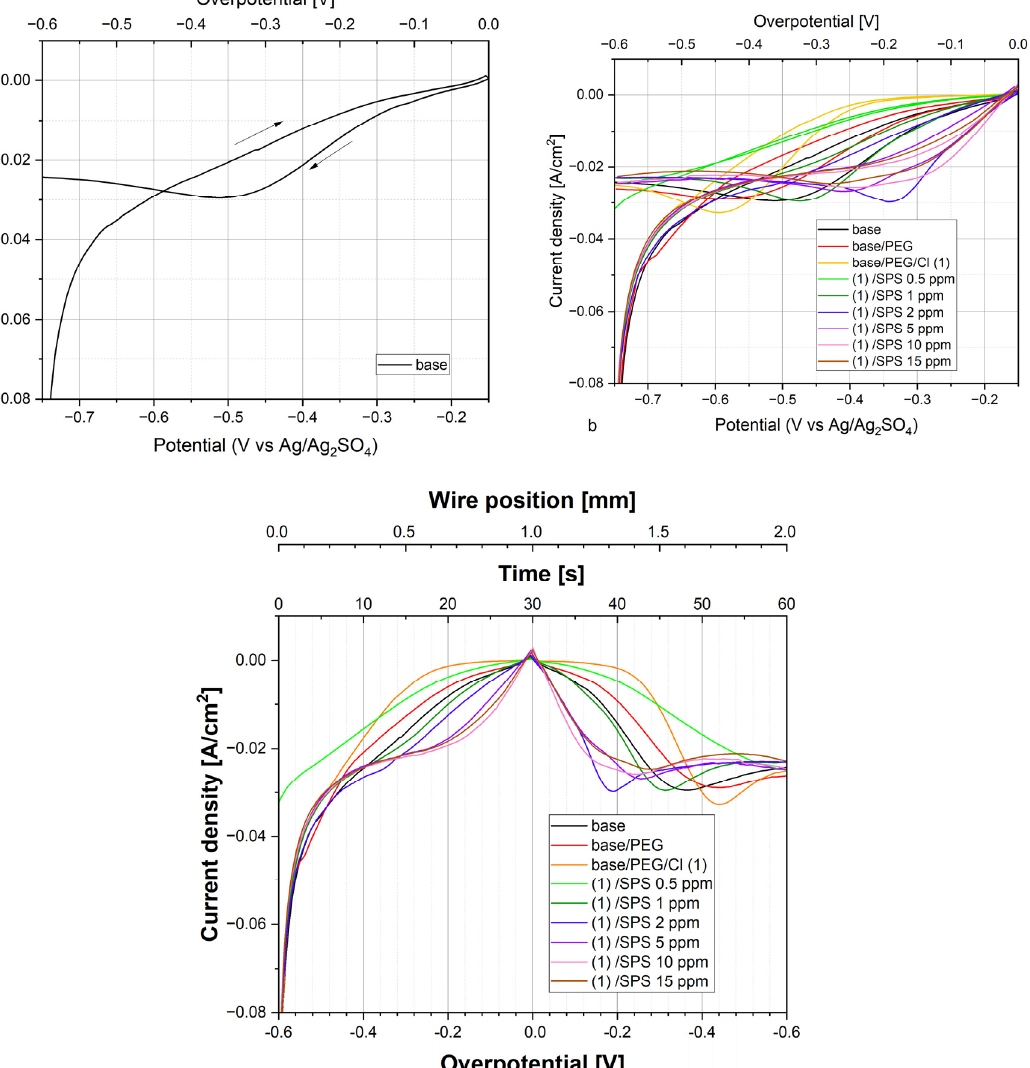
Figure 1. ( a ) Cyclic voltammetry curve recorded for the base electrolyte. ( b ) Cyclic voltammetry curves recorded for the base electrolyte and after the addition of 400 ppm of PEG8000, 30 ppm of Cl, and SPS at concentrations of 0.5, 1, 2, 5, 10, and 25 ppm. Due to the very stable value of OCP (Figure S1, Supplementary Materials) that equaled − 151mV +/ − 2 mV for all samples’ overpotential is also shown in the top axis. ( c ) CV curves shown as a function of time. The time from 0 to 30 s and the overpotential from − 0.6 to 0 V (OCP) corresponds to the forward scan, while the time from 30 to 60 s and the overpotential from 0 (OCP) to − 0.6 V corresponds to the reverse scan that was shown in Figure 1a,b, respectively. The wire position from 0 to 1 mm corresponds to the forward scan from − 0.6 V to OCP (overpotential 0 V), while the wire position from 1 to 2 mm corresponds to the reverse scan from OCP to − 0.6